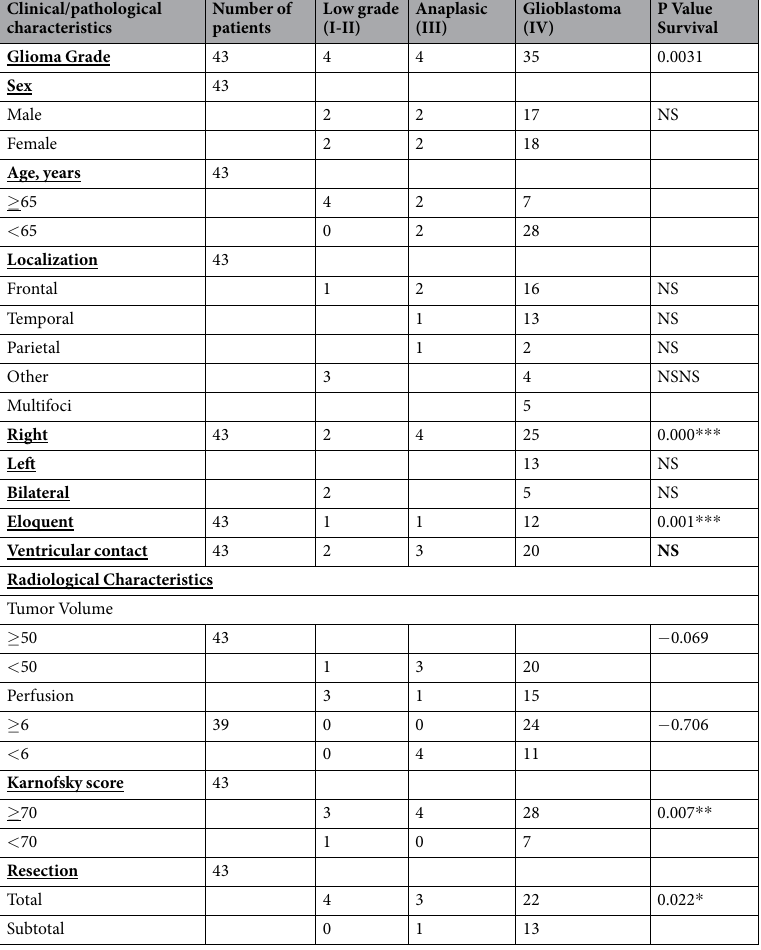
Table 1. Clinical and radiological characteristics of the glioma cohort from Donostia Hospital.